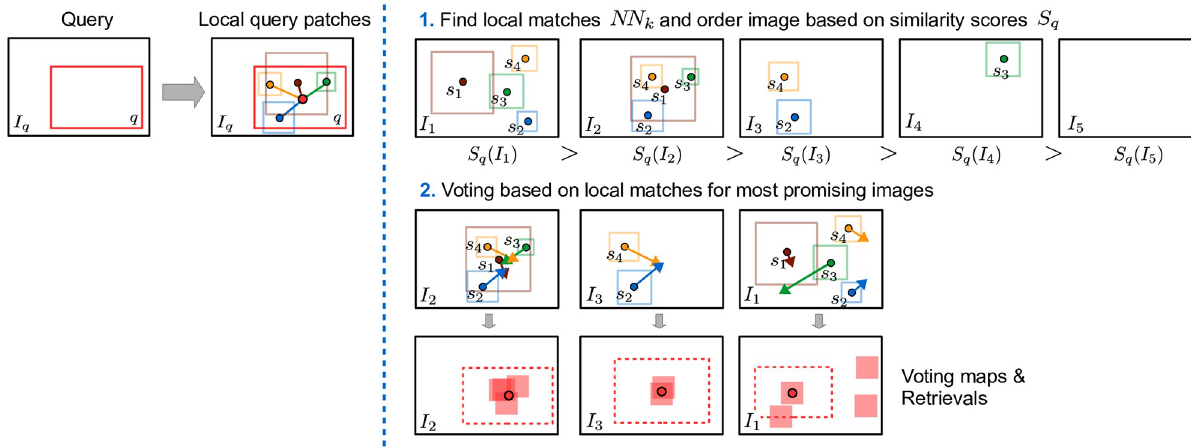
Fig 6. Overview of our voting based on local matches. The voting consists of two main steps. First, for each local query patch, we search for its k- nearest neighbors across the dataset, order all images based on their sum of local matching scores, and focus on the images with the highest score. Second, each local match votes for a specific center and scale of the retrieval bounding box, which are aggregated to the final retrieval results.